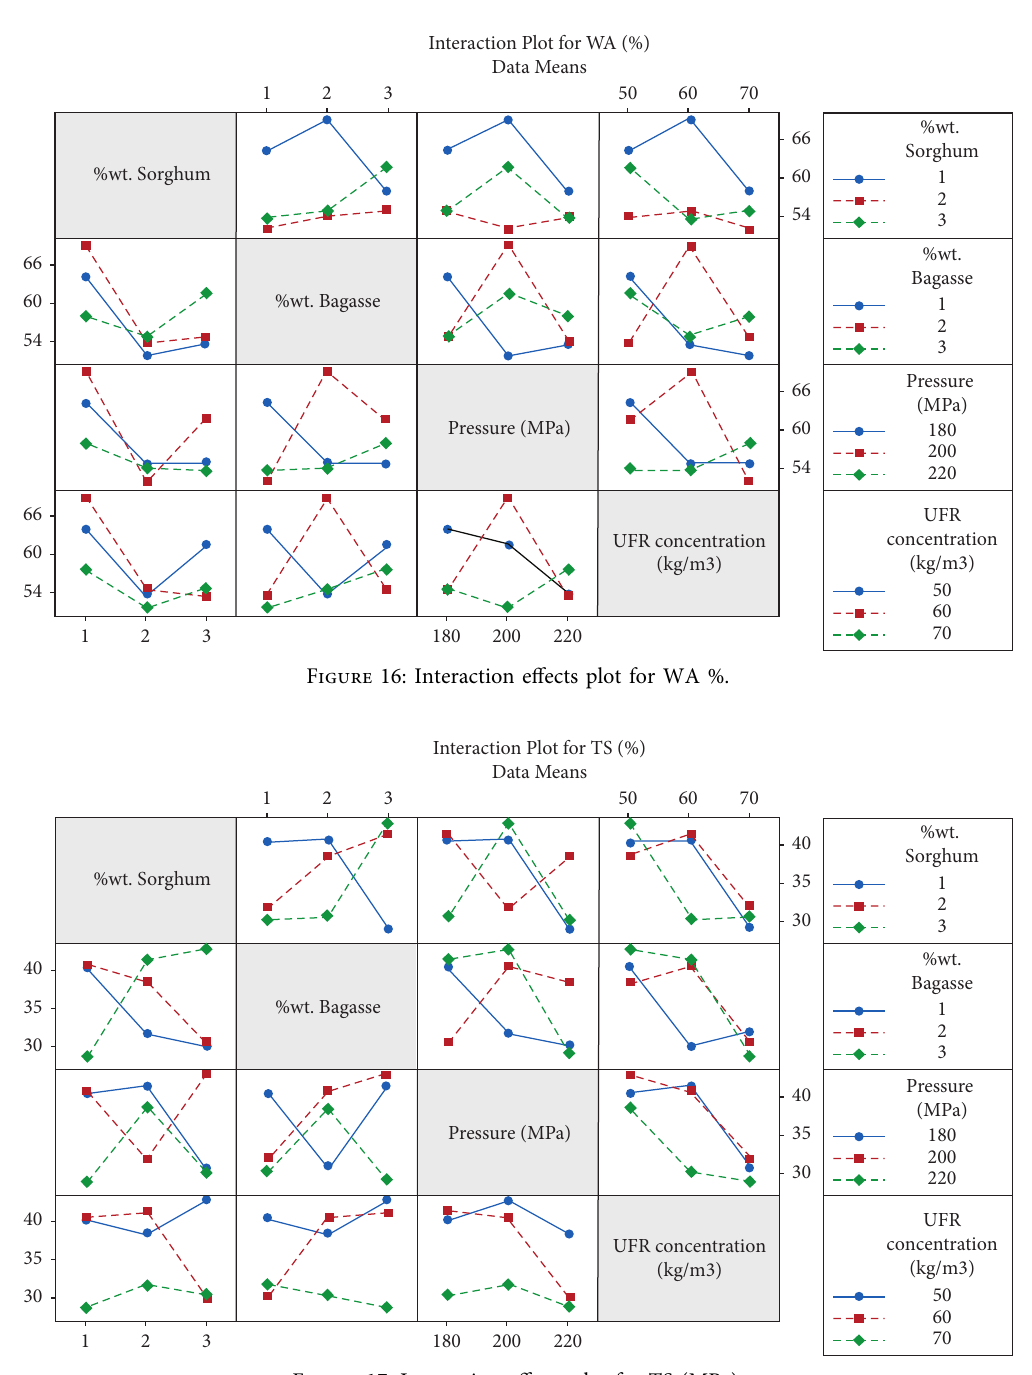
Figure 17: Interaction effects plot for TS